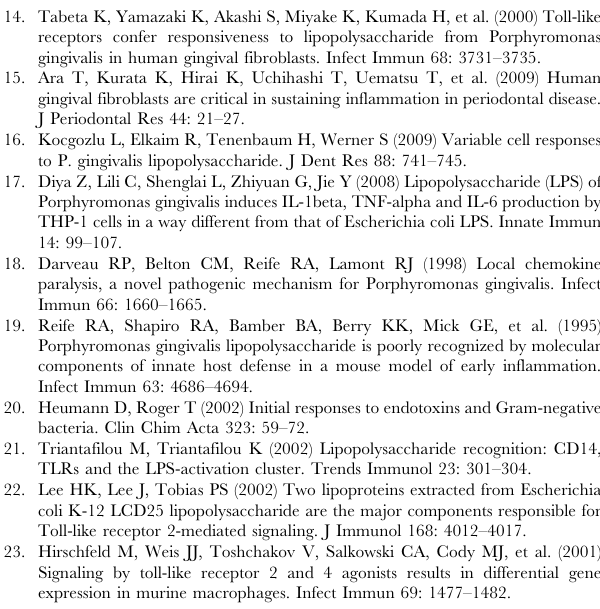
Figure S3 P. gingivalis (Pg) LPS 1690 induced the mRNA expression of inflammatory mediators in HGFs. The cells were stimulated with PgLPS and E. coli LPS (1 m g/mL) for 24 h. Figure S4 Kinetics of protein kinase B (PKB) or AKT phosphorylation in HGFs. The cells were stimulated with P. gingivalis (Pg) LPS 1435/1449 ( PgLPS 1435/1449 ) (A), PgLPS 1690 (B) and E. coli LPS (C) at 1 m g/mL for the indicated periods of time. Cell